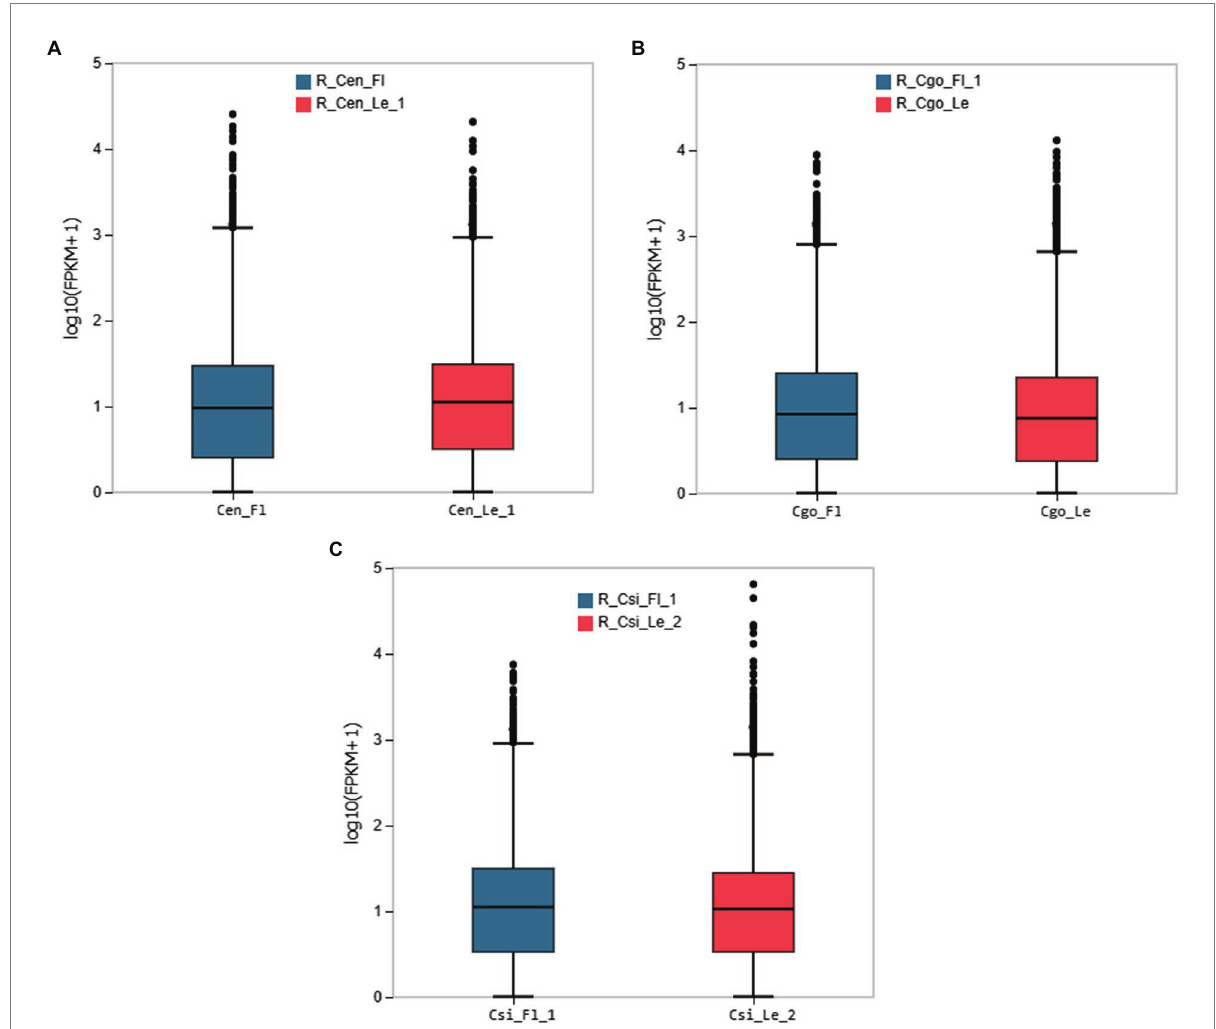
FIGURE 1 The boxplot distribution of gene expression from the two tissues of each species; (A) C. ensifolium , (B) C. goeringii , (C) C. sinense . The X-axis shows the sample name; the Y-axis represents log10(FPKM+1). The boxplot of each area shows five statistics (from top to bottom are the upper limit, upper quartile, median, and lower quartile,